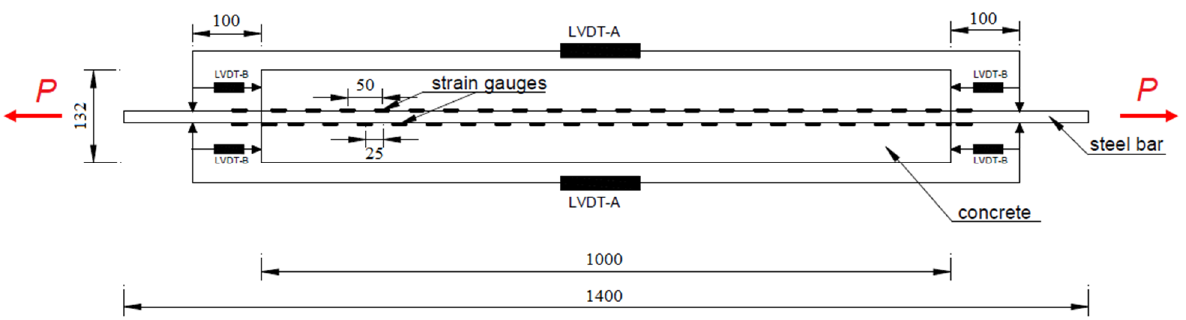
Figure 5. Layout of the test specimen L = 1000 mm under axial load (unit: mm).